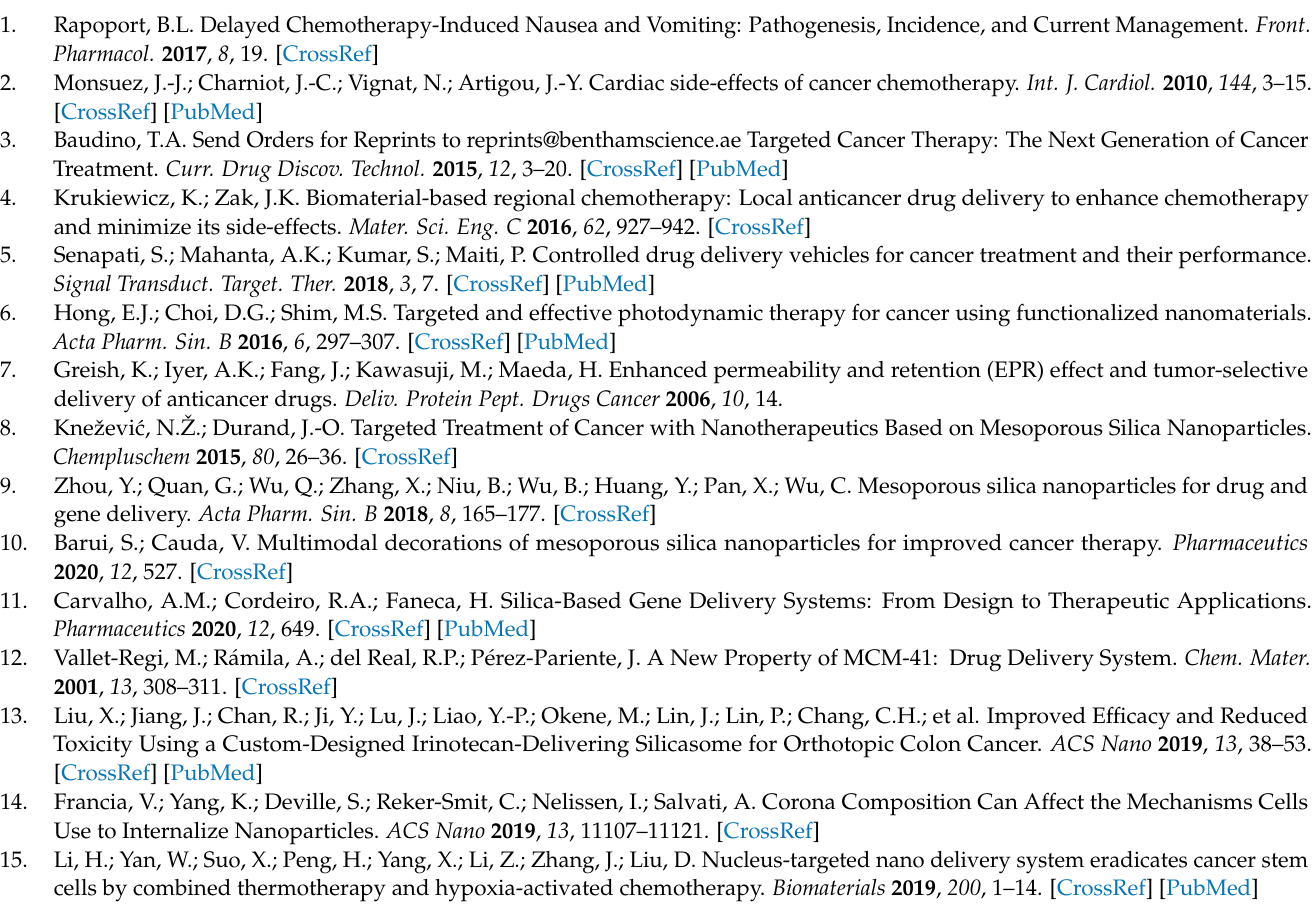
48 h of stirring, Figure S5: Viability of the B16F1 cells determined with CV and MTT assays treated (48 h) with pristine MSN on pH 5.0 and